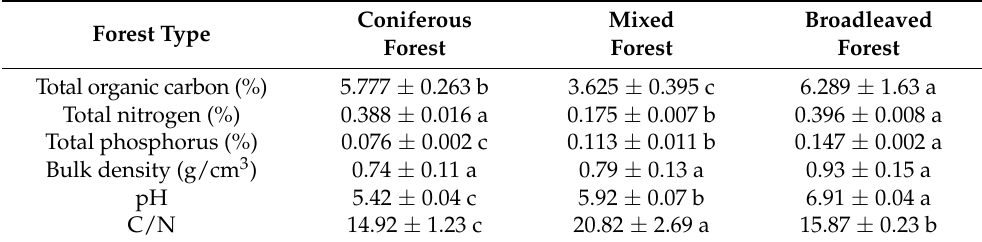
Table 2. Soil initial properties of three forest soils (mean ± standard error, n =